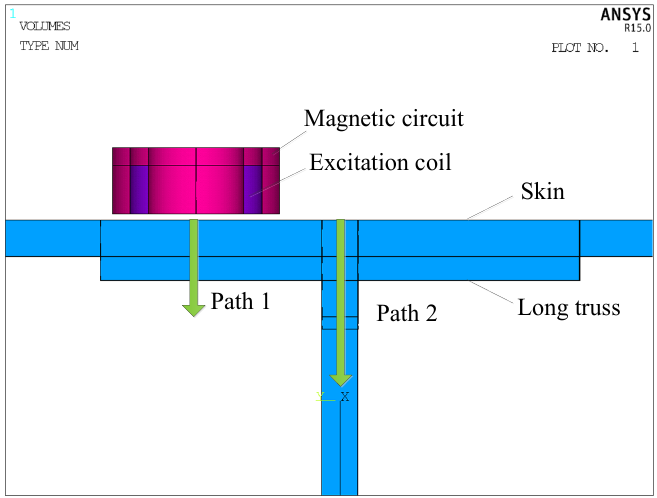
Figure 7. Schematic diagram of magnetic field strength extraction path setting.